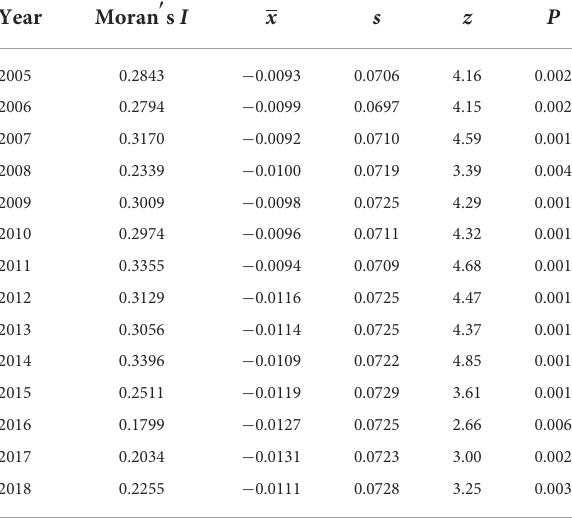
TABLE 1 Results of global spatial autocorrelation for incidence of syphilis in Zhejiang Province,